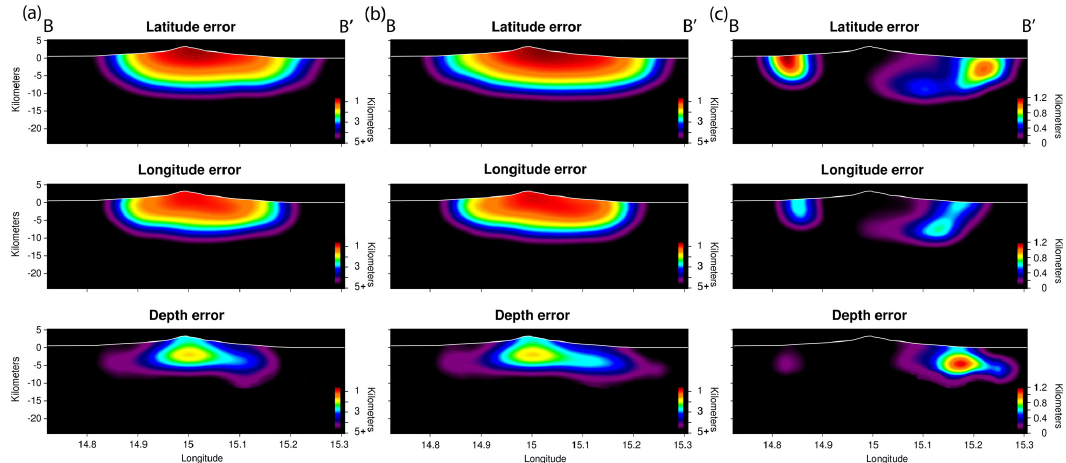
Fig. 9. Vertical section of hypocenter location uncertainty estimates between points B (37.75 ◦ N, 14.72 ◦ E) and B 0 (37.75 ◦ N, 15.31 ◦ E), for M L 1.5 and confidence level of 95% (see Fig. 3), respectively for (a) ESN, (b) ESN + CS and (c) (ESN + CS)-ESN.